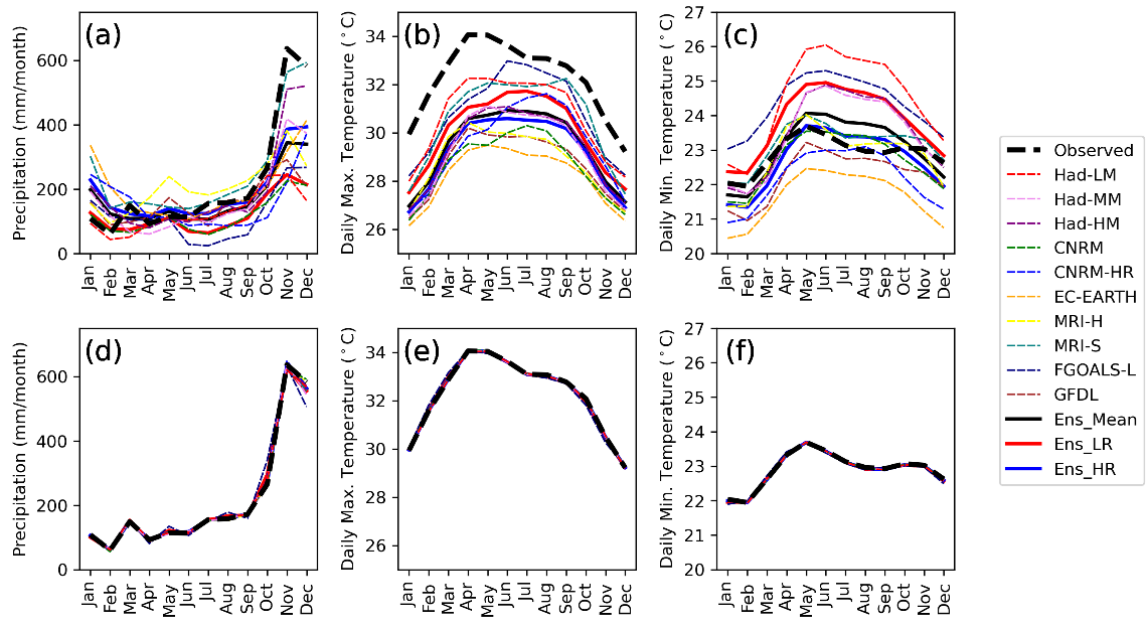
Figure 4. The annual cycles of monthly precipitation amount ( a , d ), monthly mean daily maximum ( b , e ) and minimum temperature ( c , f ) for the ten CMIP6 HighResMIP experiments, compared to the MMD observations during the period 1980~2014: ( a – c ) original; ( d – f ) bias-corrected for the Kelantan River Basin, Malaysia.